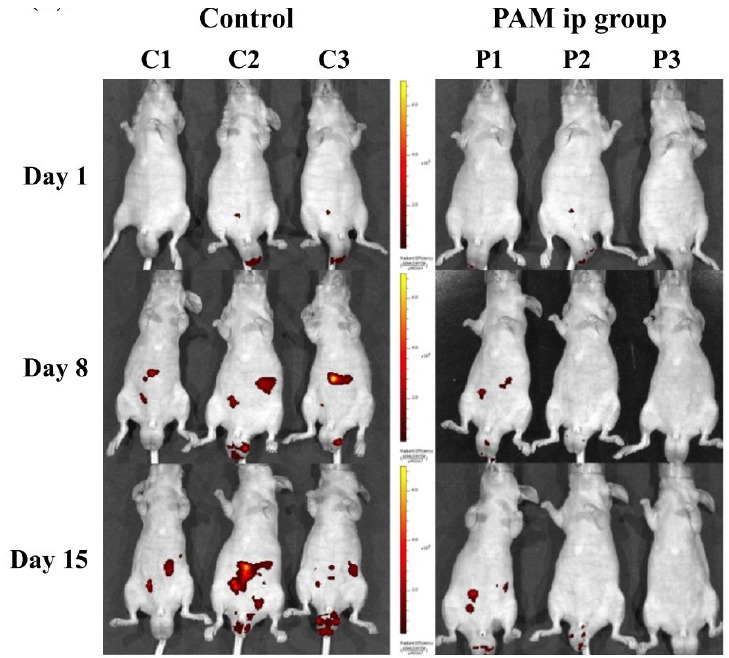
Figure 14. Efficacy of the intraperitoneal administration of PTS (“PAM”) in vivo. Reproduced from [78] . Copyright 2017 Springer Nature. from [78]. Copyright 2017 Springer